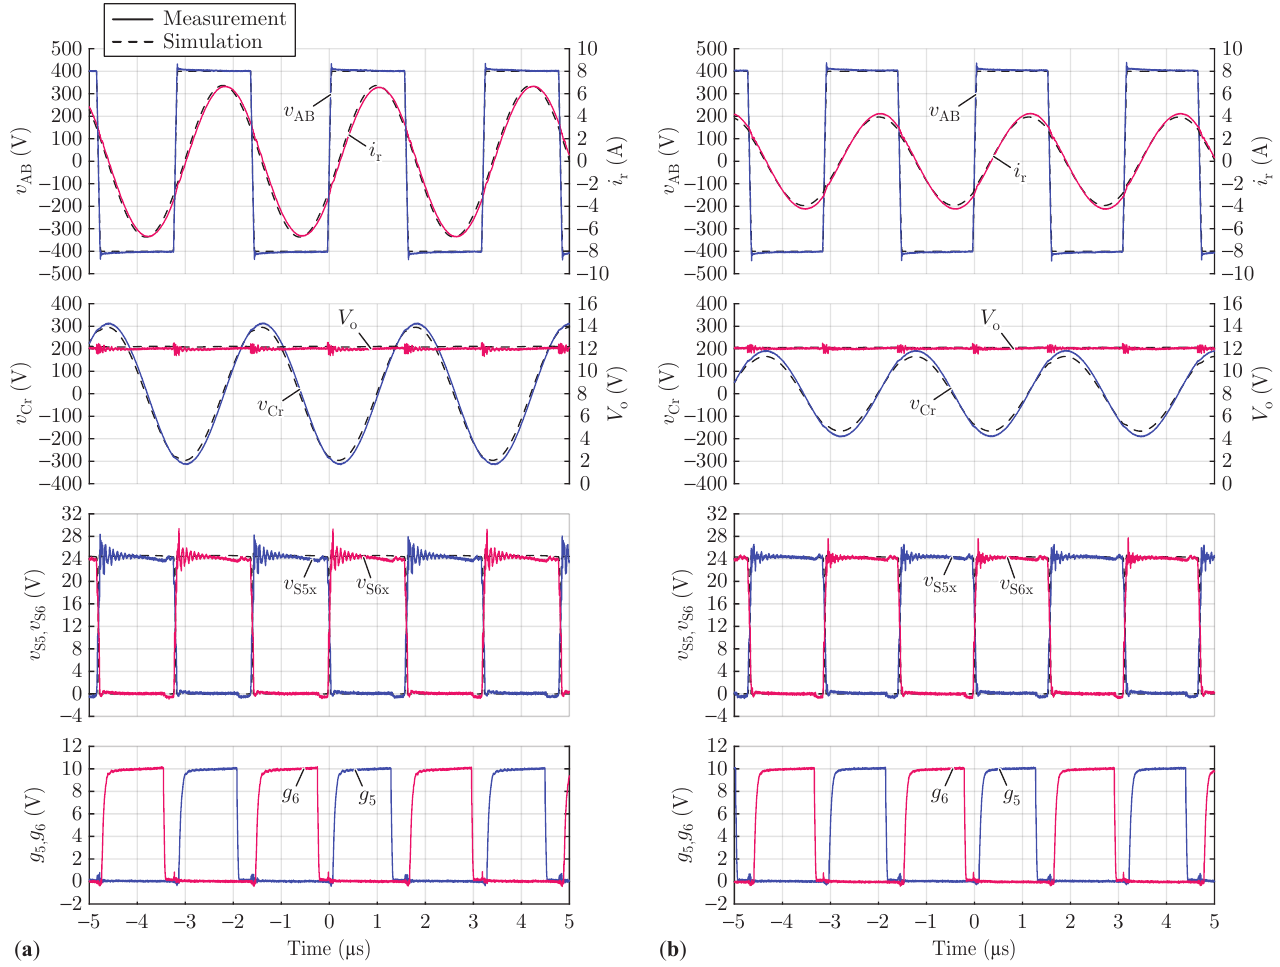
Figure 12. Key operating waveforms captured at ( a ) nominal and ( b ) 50% load, demonstrating good agreement with circuit-simulation data (shown as dashed lines). Output voltage ( V o ) is regulated at 12V by controlling the switching frequency of v AB . The sinusoidal shape of i r minimizes harmonic losses, and synchronous rectification supports both ZVS and ZCS of the LV-side switches (drain-to-source voltages v S5x / v S6x commute naturally at zero current) and reduces body-diode losses by conducting most of the current through the MOSFET channel (gate signals g 5 / g 6 are commanded after and before switching